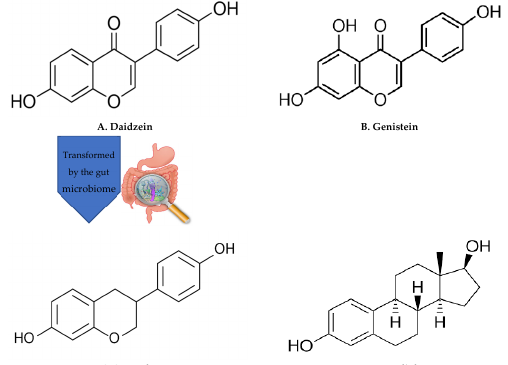
Figure 1. Chemical structures of daidzein, genistein (two major soy isoflavones), equol, and estra ‐ diol. Daidzein and genistein are two major soy isoflavones and comprise >95% of their dietary source. Soy isoflavones and S ‐ equol are structurally similar to estradiol. S ‐ equol is a metabolite of daidzein, transformed by the gut microbiome. Daidzein is reduced to S ‐ equol through the interme ‐ diate dihydrodaidzein and then converted by deoxygenation to yield S ‐ eqol. [27] Daidzein, genistein and equol are structurally similar to estradiol (images of chemical structures are from Wikimedia Commons and Pixabay).